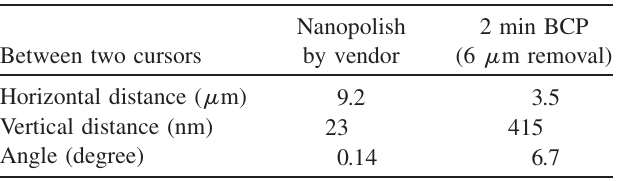
TABLE III. Lateral lengths and angles between the given two cursors shown in Fig. 13.